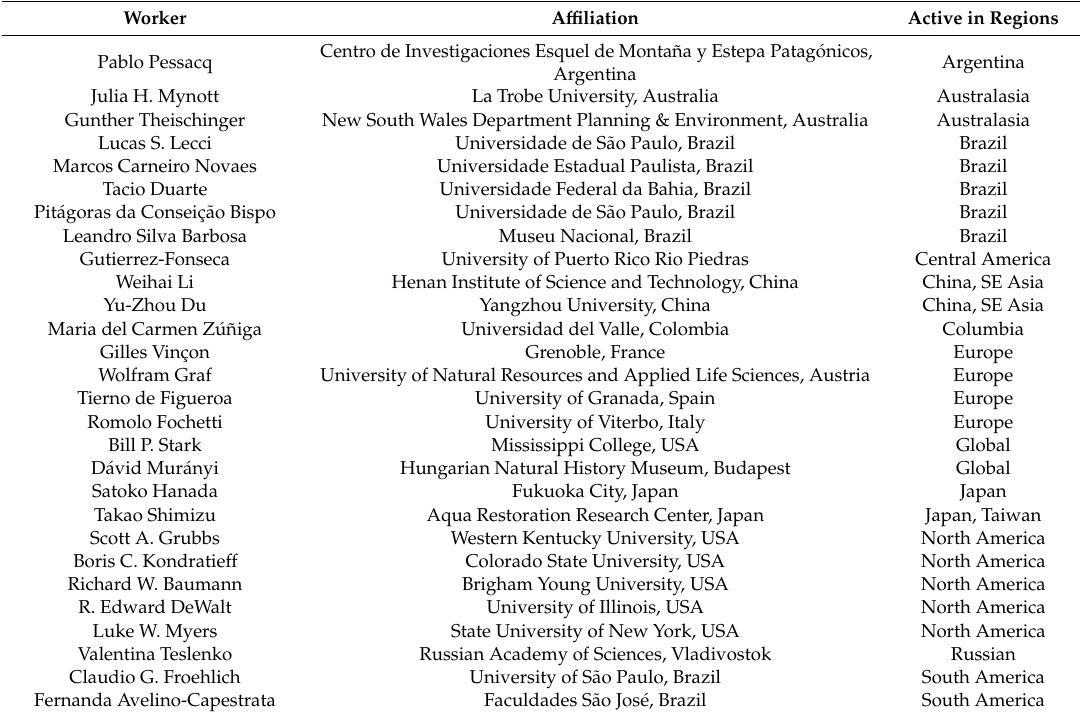
Table 4. Laboratories making recent contributions to Plecoptera species description. A ffi liated workers and graduate students have been omitted due to space